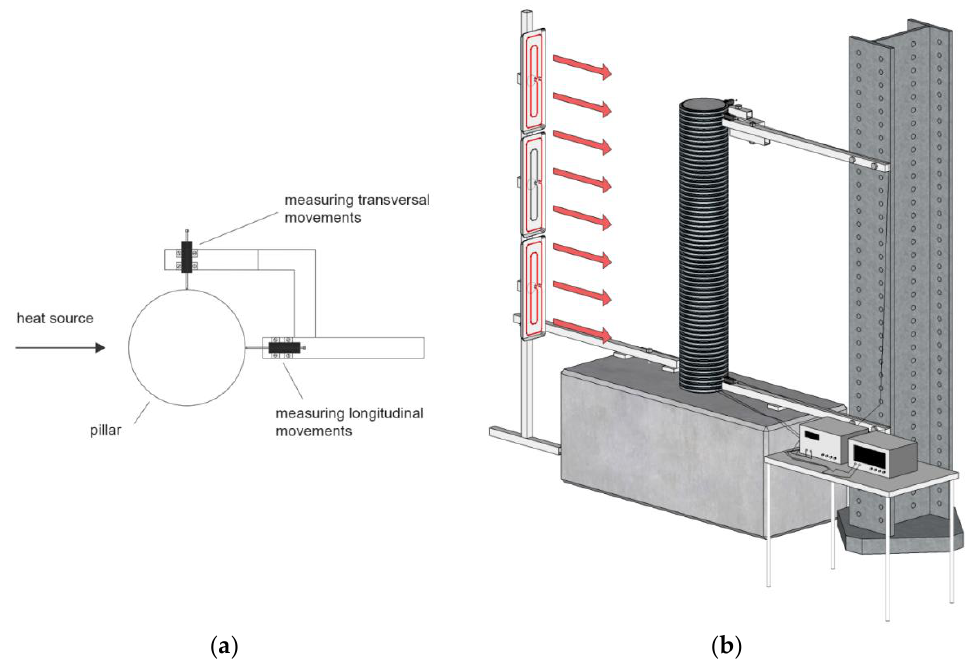
Figure 7. ( a ) The position of the displacement sensor at the top of the pillar; ( b ) The scheme of the experiment (the red arrows indicate the direction of the heat flow).